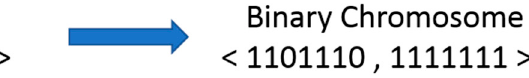
Figure 8. Structure of the chromosome and 7-bit binary encoding.